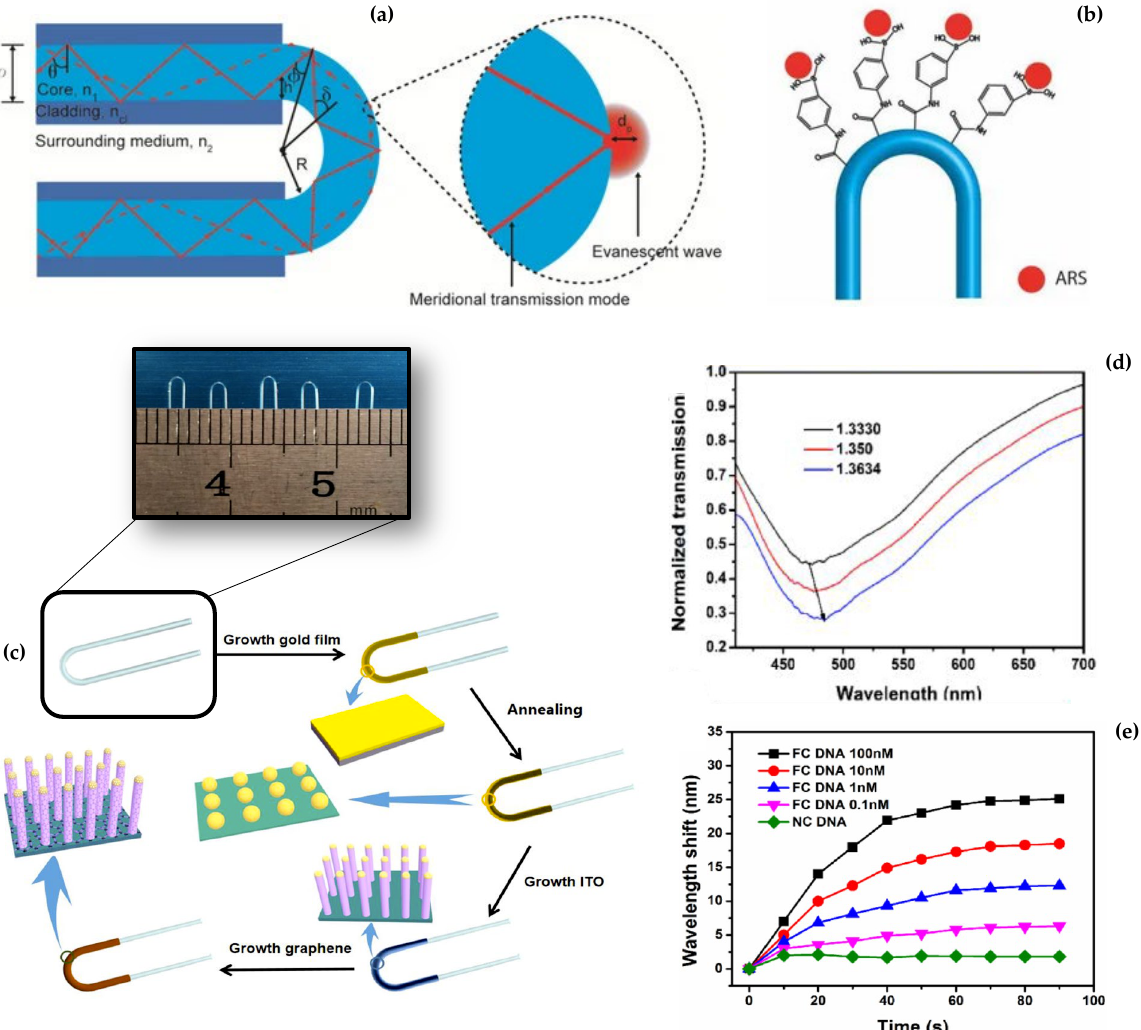
Figure 3. Schematic and implementation of U-shape fiber biosensors: schematic of a U-bent fiber section with light propagation within the curved portion of the fiber ( a ) with inset showing the surface-penetrating meridional rays providing RI sensitivity, and functionalization of the biosensor for glucose detection ( b ) (ARS—Alizarin Red S) (images reproduced from [27]); ( c ) U-bent LSPR sensor proposed by Yang et al. with the respective production steps, namely, U-shape production and photographs, and formation of ITO coating for plasmonic-based sensing, with results of the change in transmission spectrum for three different values of RI ( d ) and the response of the sensor, measuring the wavelength shift over time, for different DNA concentrations ( e ) (images adapted from [28]).